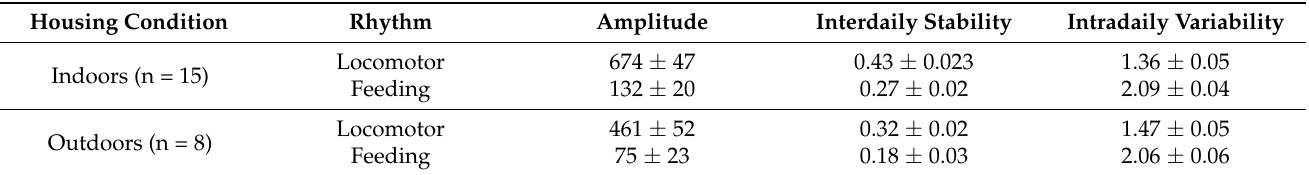
Table 3. Mean ± SE of amplitude, interdaily stability and intradaily variability according to the rhythm (locomotor versus feeding) and the housing condition of the cats.